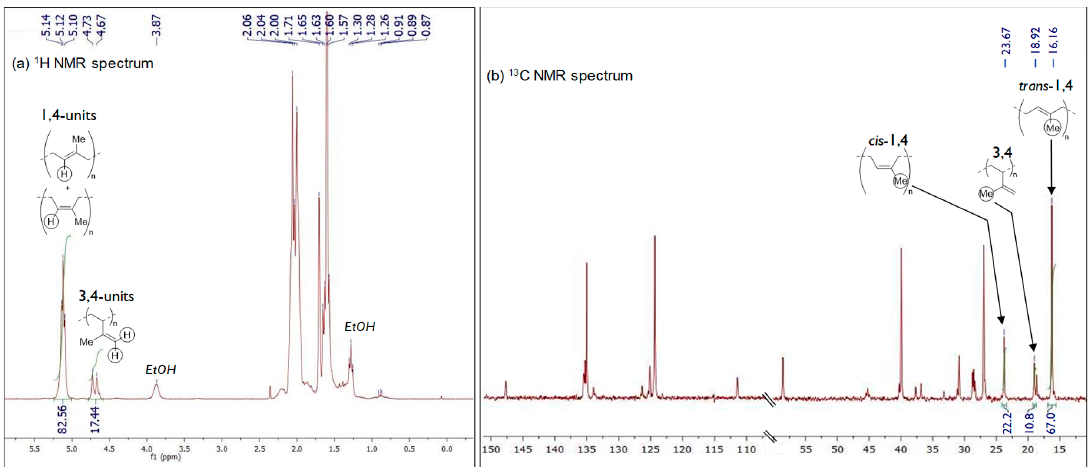
Figure 3. NMR spectra (in CDCl 3 ) of the PI obtained from C1 /Al i Bu 3 /[Ph 3 C][B(C 6 F 5 ) 4 ] (Table 1, entry 1) showing the characteristic resonances of 1,4- and 3,4-units ( 1 H-NMR, left) and trans / cis configuration ( 13 C-NMR, right).